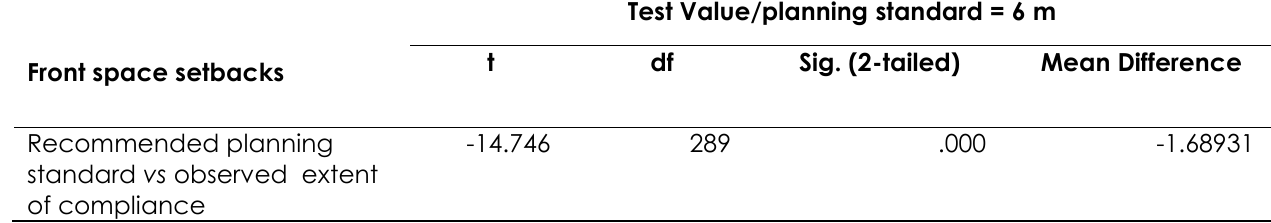
Table 6: Significance test for the first hypothesis.